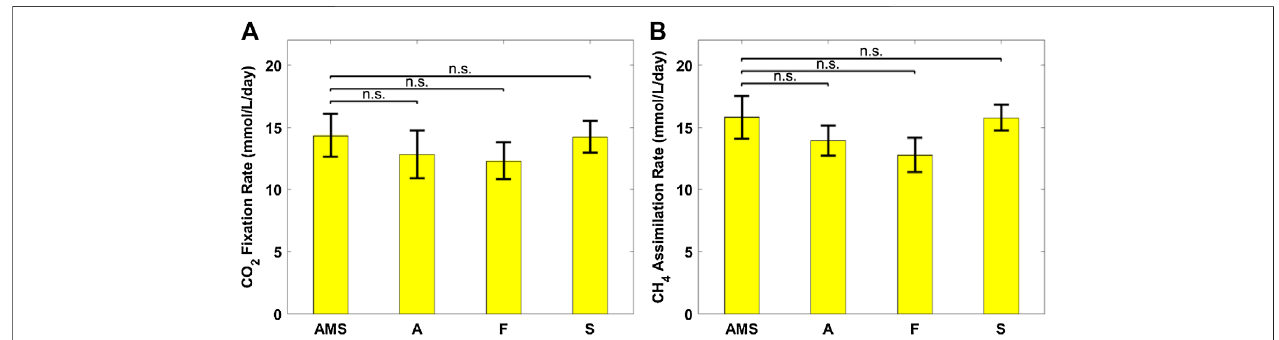
FIGURE 7 | (A) CO 2 fi xation rate of Chlorella sorokiniana and (B) CH 4 assimilation rate of Methylococcus capsulatus . The Dunnett ’ s test, with ammonium mineral salts (AMS) as the control, indicates that these differences are not signi fi cant (n.s.) statistically at signi fi cance level α (cid:2) 0.05.